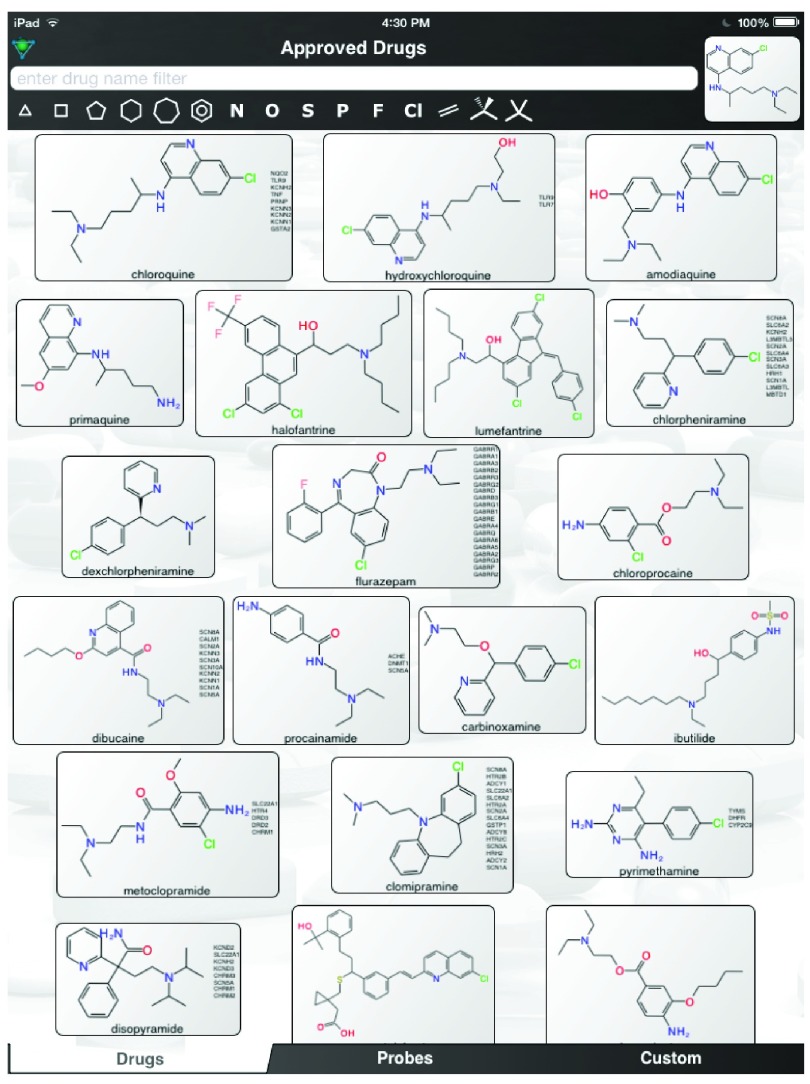
Chloroquine similarity in Approved Drugs mobile app
http://molmatinf.com/approveddrugs.html.